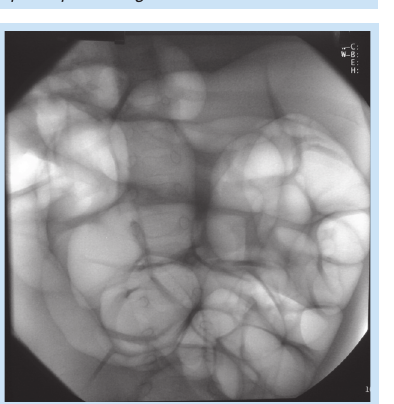
Fig. 5. Post reduction, there has been free flow of air into the small bowel indicating success of the procedure. Comparison with the initial image (Fig. 2) is